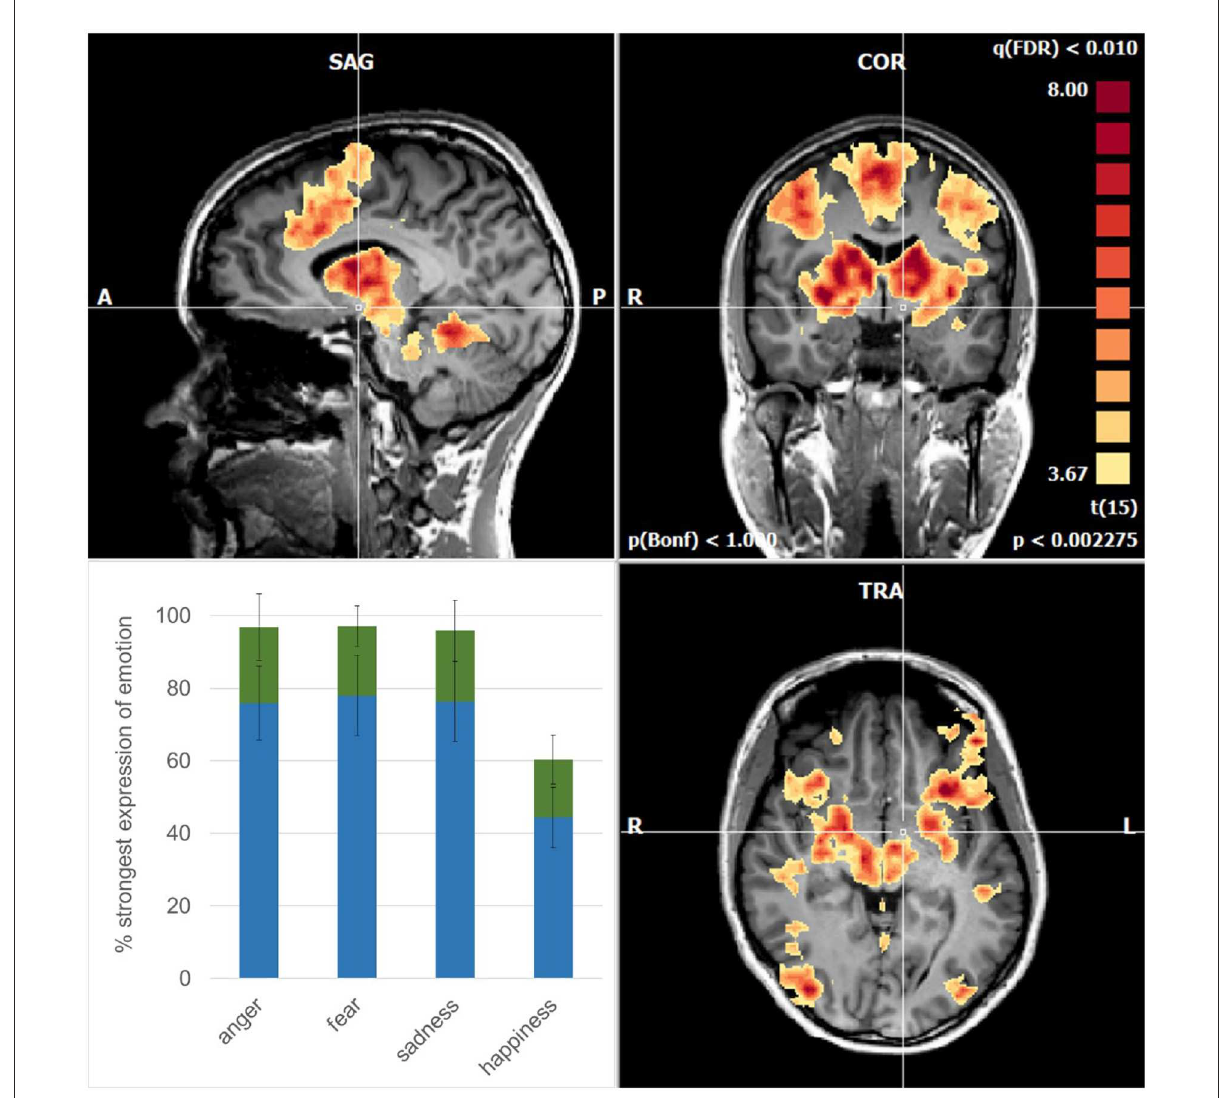
FIGURE1 Mean activations are related to the recognition of the emotions in sagittal (upper left) , coronal (upper right) , and axial planes (lower right) . Note the symmetric pattern involves cortical areas and subcortical structures such as the basal ganglia, thalamus, amygdala, and brainstem nuclei. The cross of the stereotactic coordinates (x − 4, y − 4, z − 6) signifies the left hypothalamus that is spared. (lower left) Degree of evolution of the emotional face expressions when the subjects recognized (blue) and empathized (green) with the emotions; error bars: standard